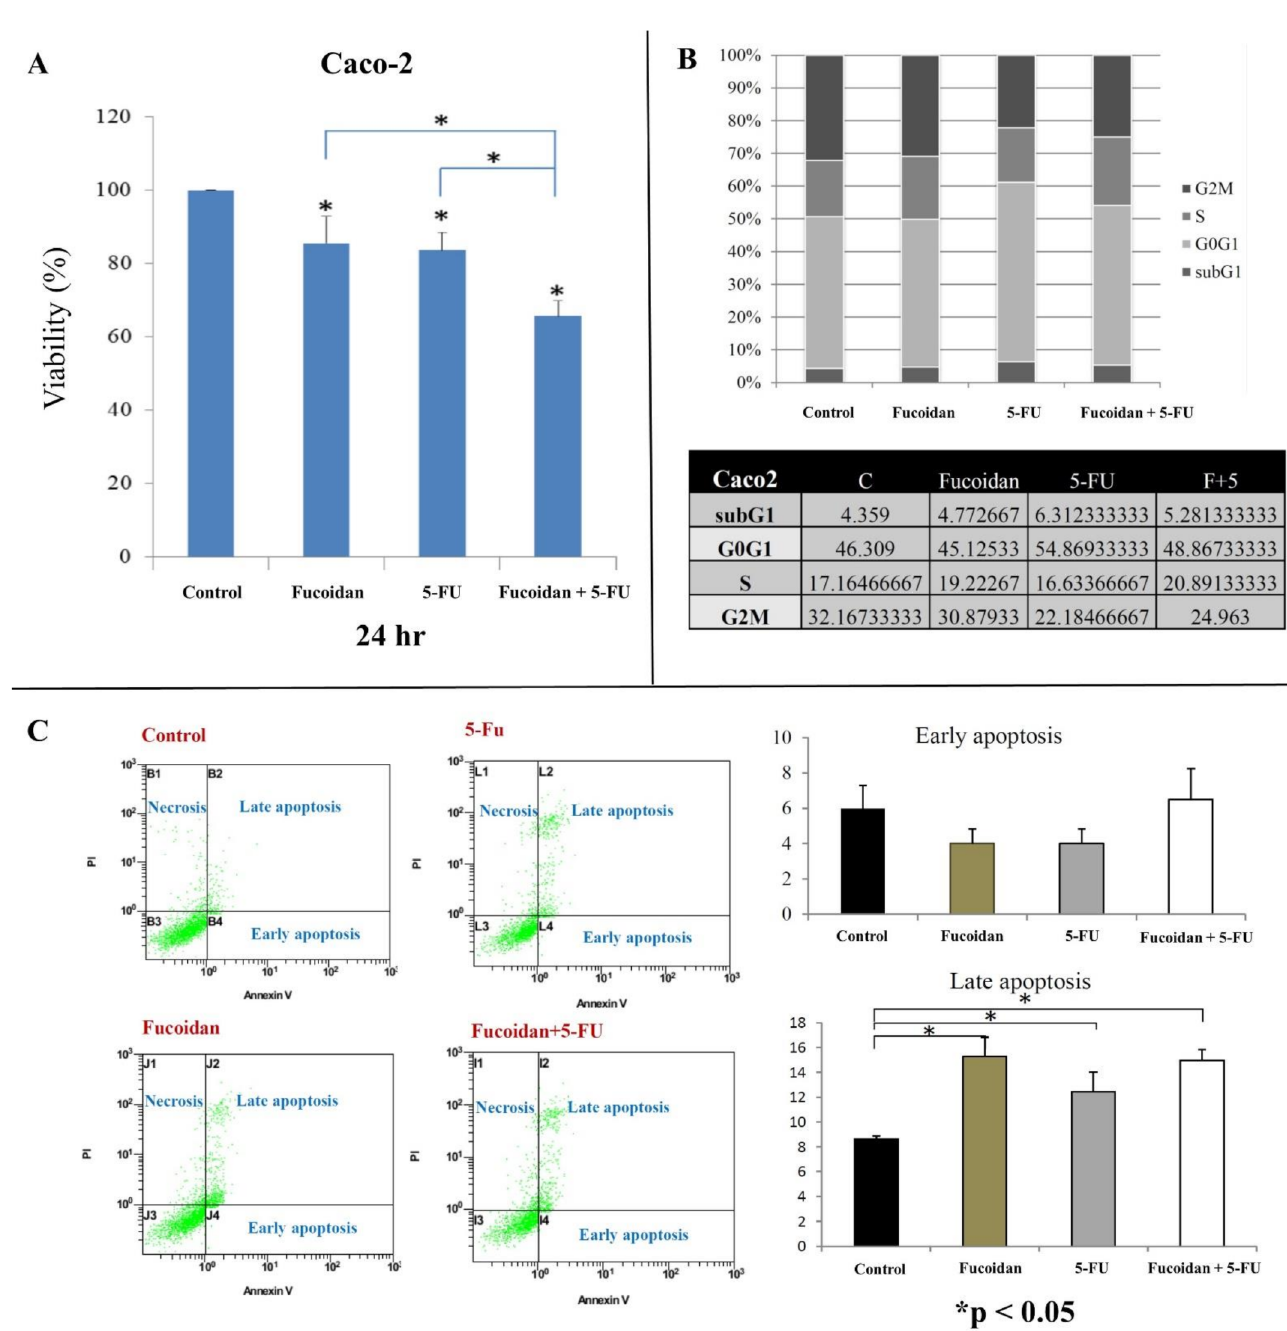
Figure 2. Effects of LMWF and 5-fluorouracil (5-FU) on viability, cell cycle, and apoptosis status of Caco-2 cells.: ( A ) cell viability of Caco-2 cells at 24 h; ( B ) cell cycle of Caco-2 cells; ( C ) cell apoptosis of Caco-2 cells. Data are presented as the mean of three independent experiments. * p <